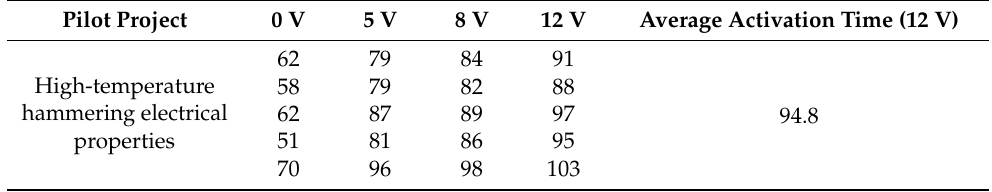
Table 2. Thermal battery activation-phase curve (time to reach the following voltages, unit